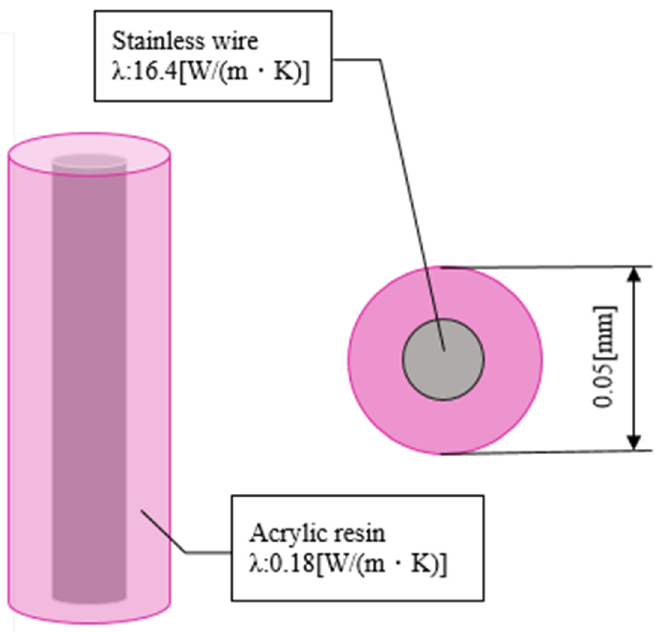
Figure 6. Analysis area and conditions of numerical simulation.